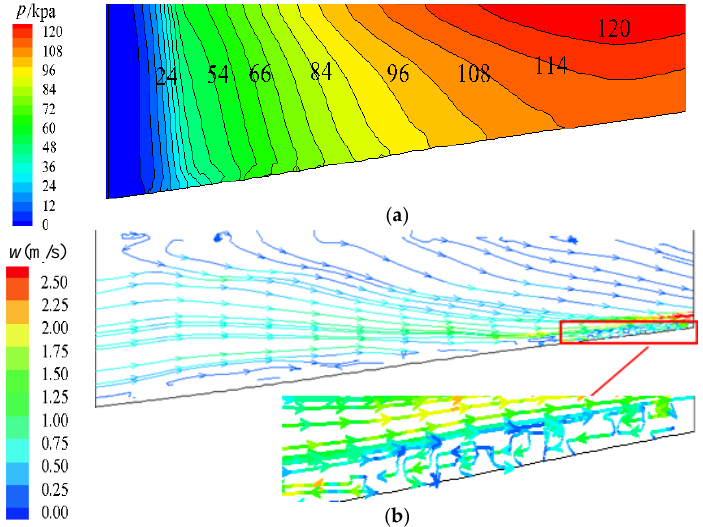
Figure 10. Pressure and streamlines distribution of S2 stream surface in middle of the impeller ( IGVF = 15%). ( a ) Pressure distribution of S2 stream surface in the middle of the impeller; ( b ) Streamlines distribution of S2 stream surface in the middle of the impeller.